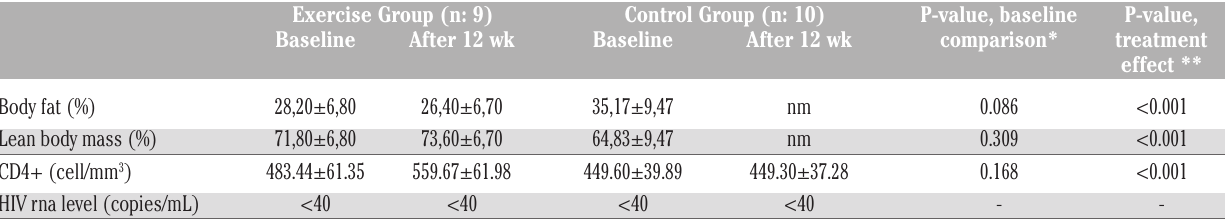
Table 2. Body composition and immune parameters.